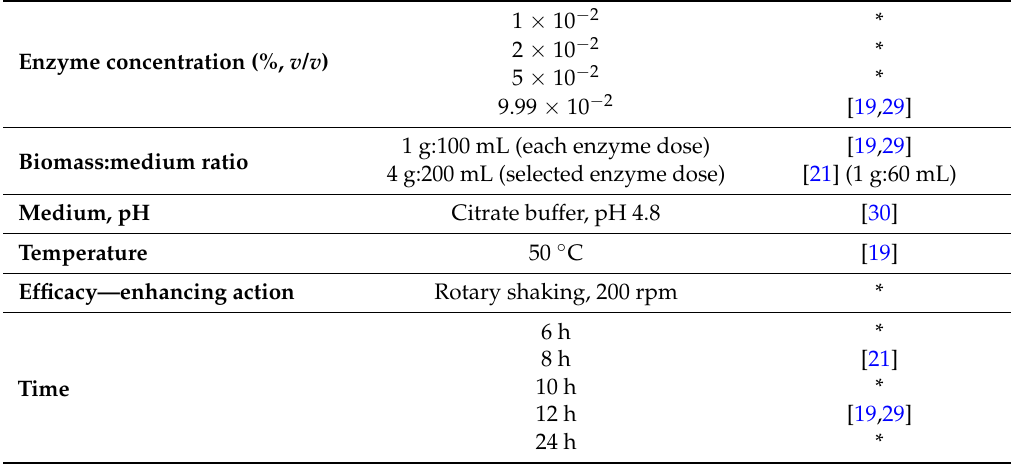
Table 5. Methodology of E. prolifera hydrolysis based on literature